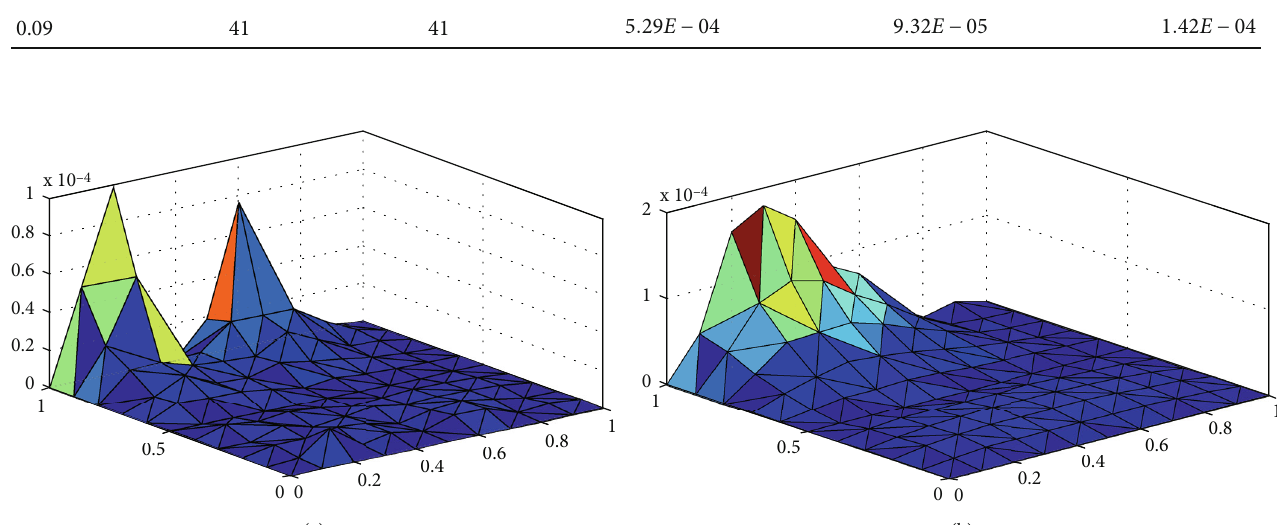
Figure 5: MAE for example 4.1 using MQ with ϵ = 0 : 02 (a) and IMQ with ϵ = 0 : 08 (b) with N = 11 × 11